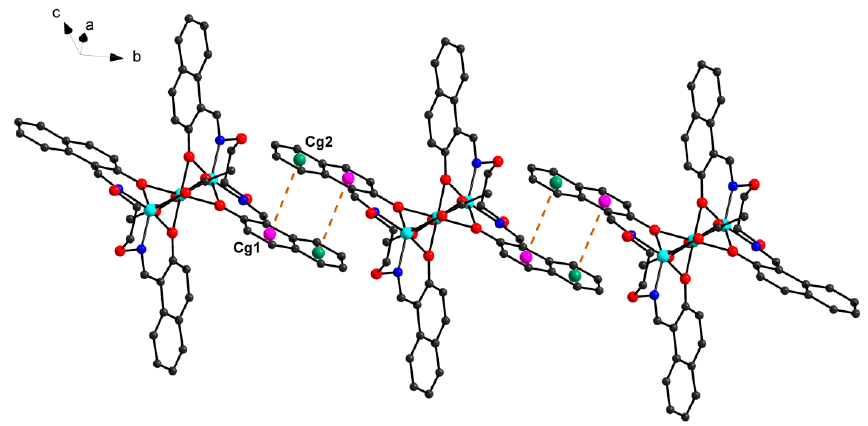
Figure 10. View of 1D supramolecular structure of the complex 2 showing the formation C-H··· π stacking interaction.